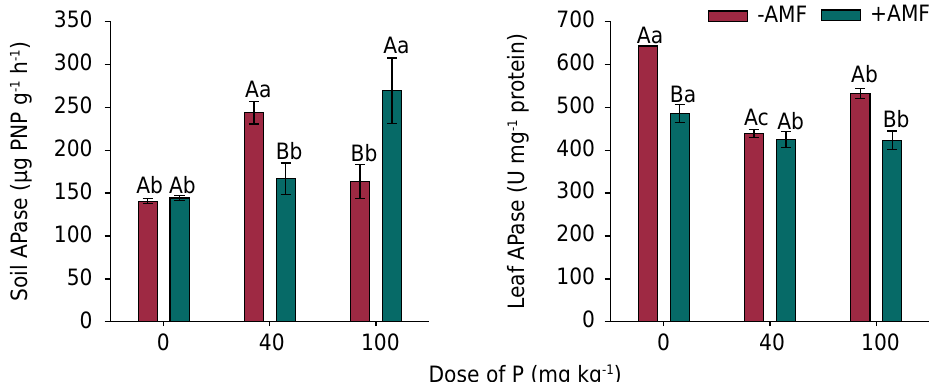
Figure 5. Enzymatic activity of soil and leaf acid phosphatase (APase) in Crotalaria juncea plants growing in a soil with high copper (60 mg kg -1 ) levels under different phosphorus levels with and without AMF inoculation. Vertical bars above the columns indicate the standard deviation. Means followed by the same lowercase letter compare doses in the same condition inoculation and uppercase letters compare inoculation within the same dose of P (Tukey 5